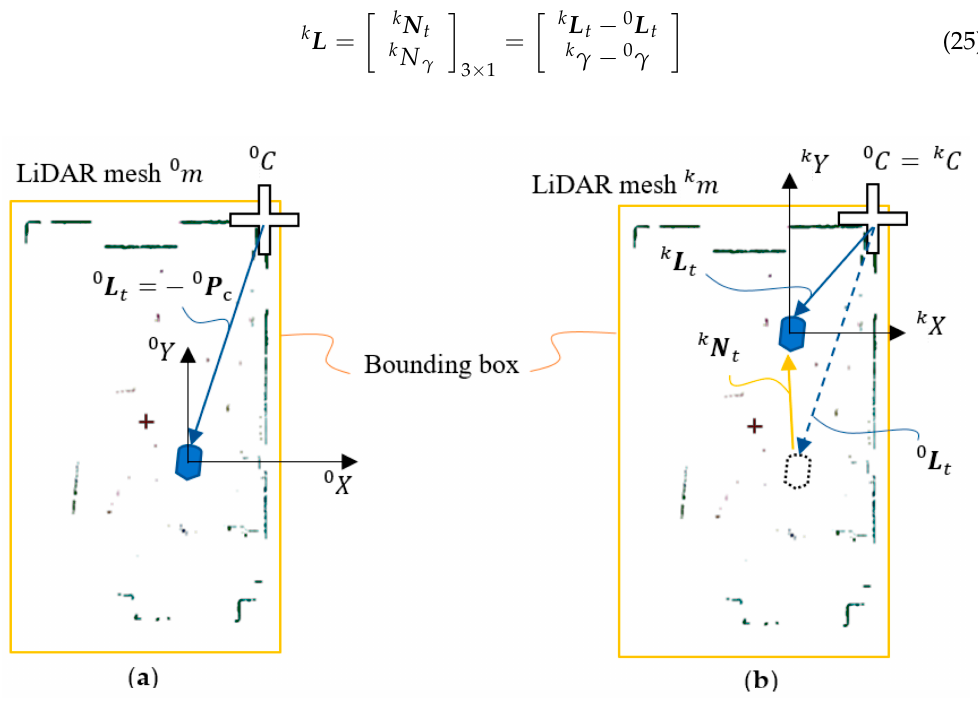
Figure 7. Determination of the ( a ) LiDAR pose frames, ( b ) IMR